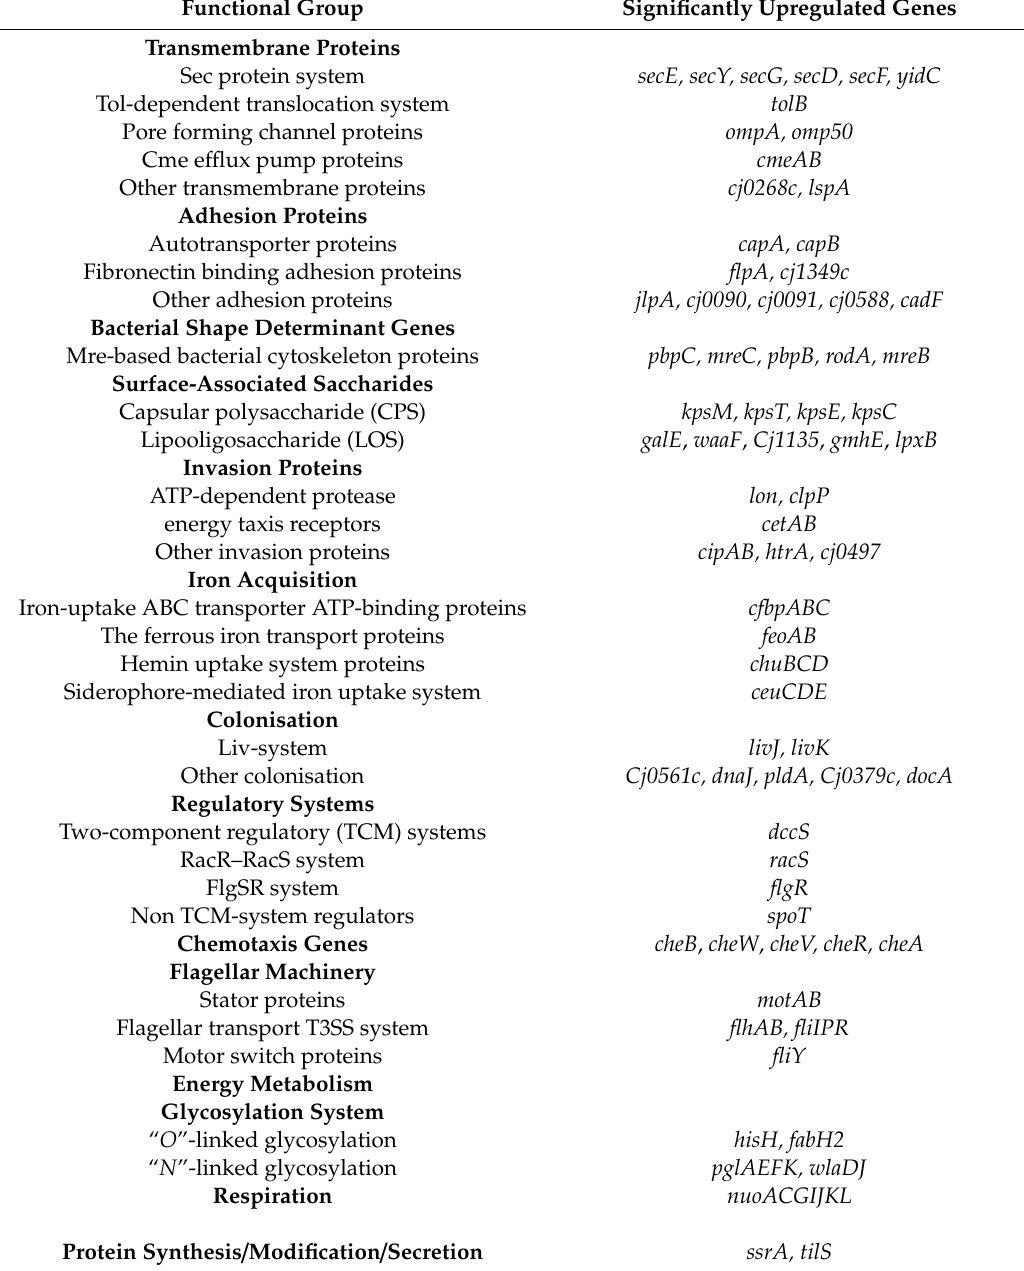
Table 2. Summary of the representative genes with significantly increased transcriptional activities at the third hour of the invasion of strain